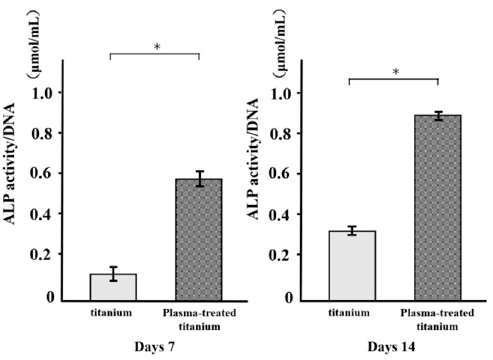
Figure 9. Alkaline Phosphatase (ALP) activity of titanium and plasma-modified titanium. There were major differences in ALP activity between the plasma-treated and titanium surfaces at days 7 and 14.